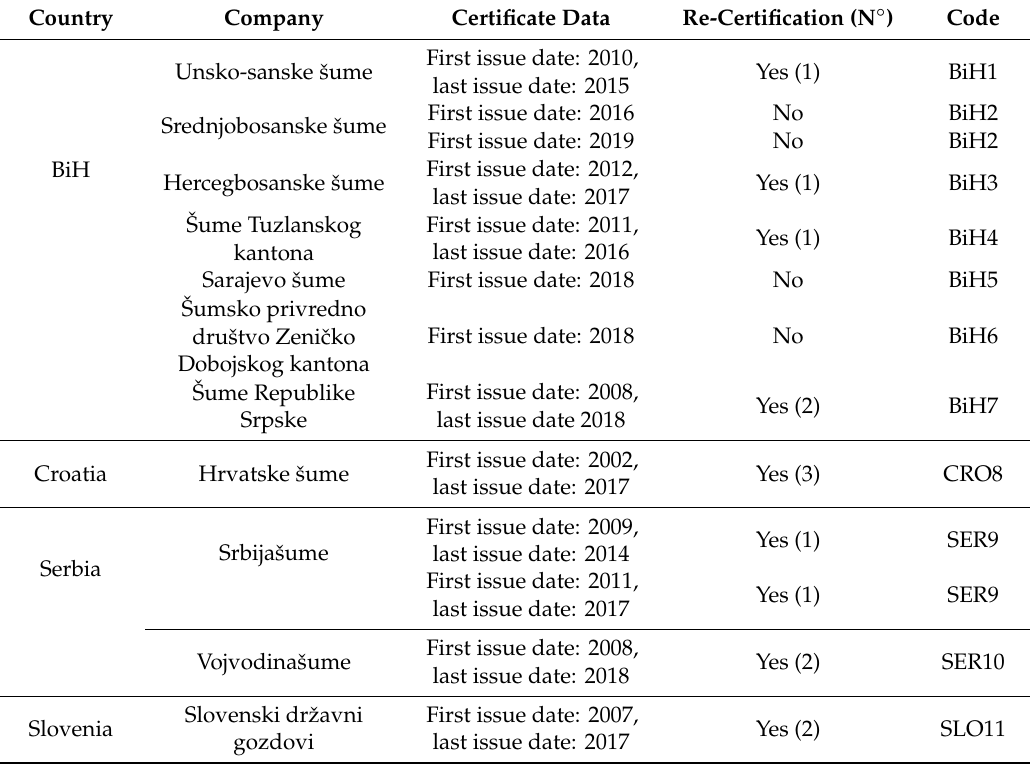
Table 2. List of valid Forest Stewardship Council (FSC)